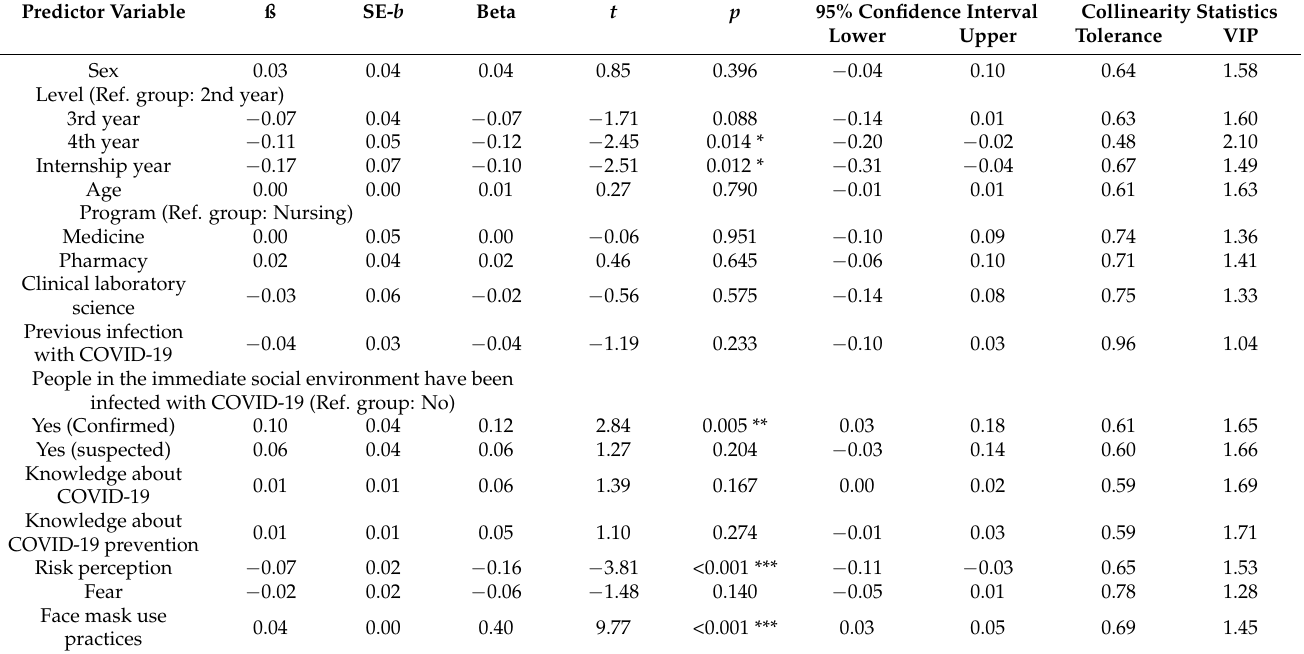
Table 5. Results of the multiple regression analysis on the students’ social distancing attitudes (n =